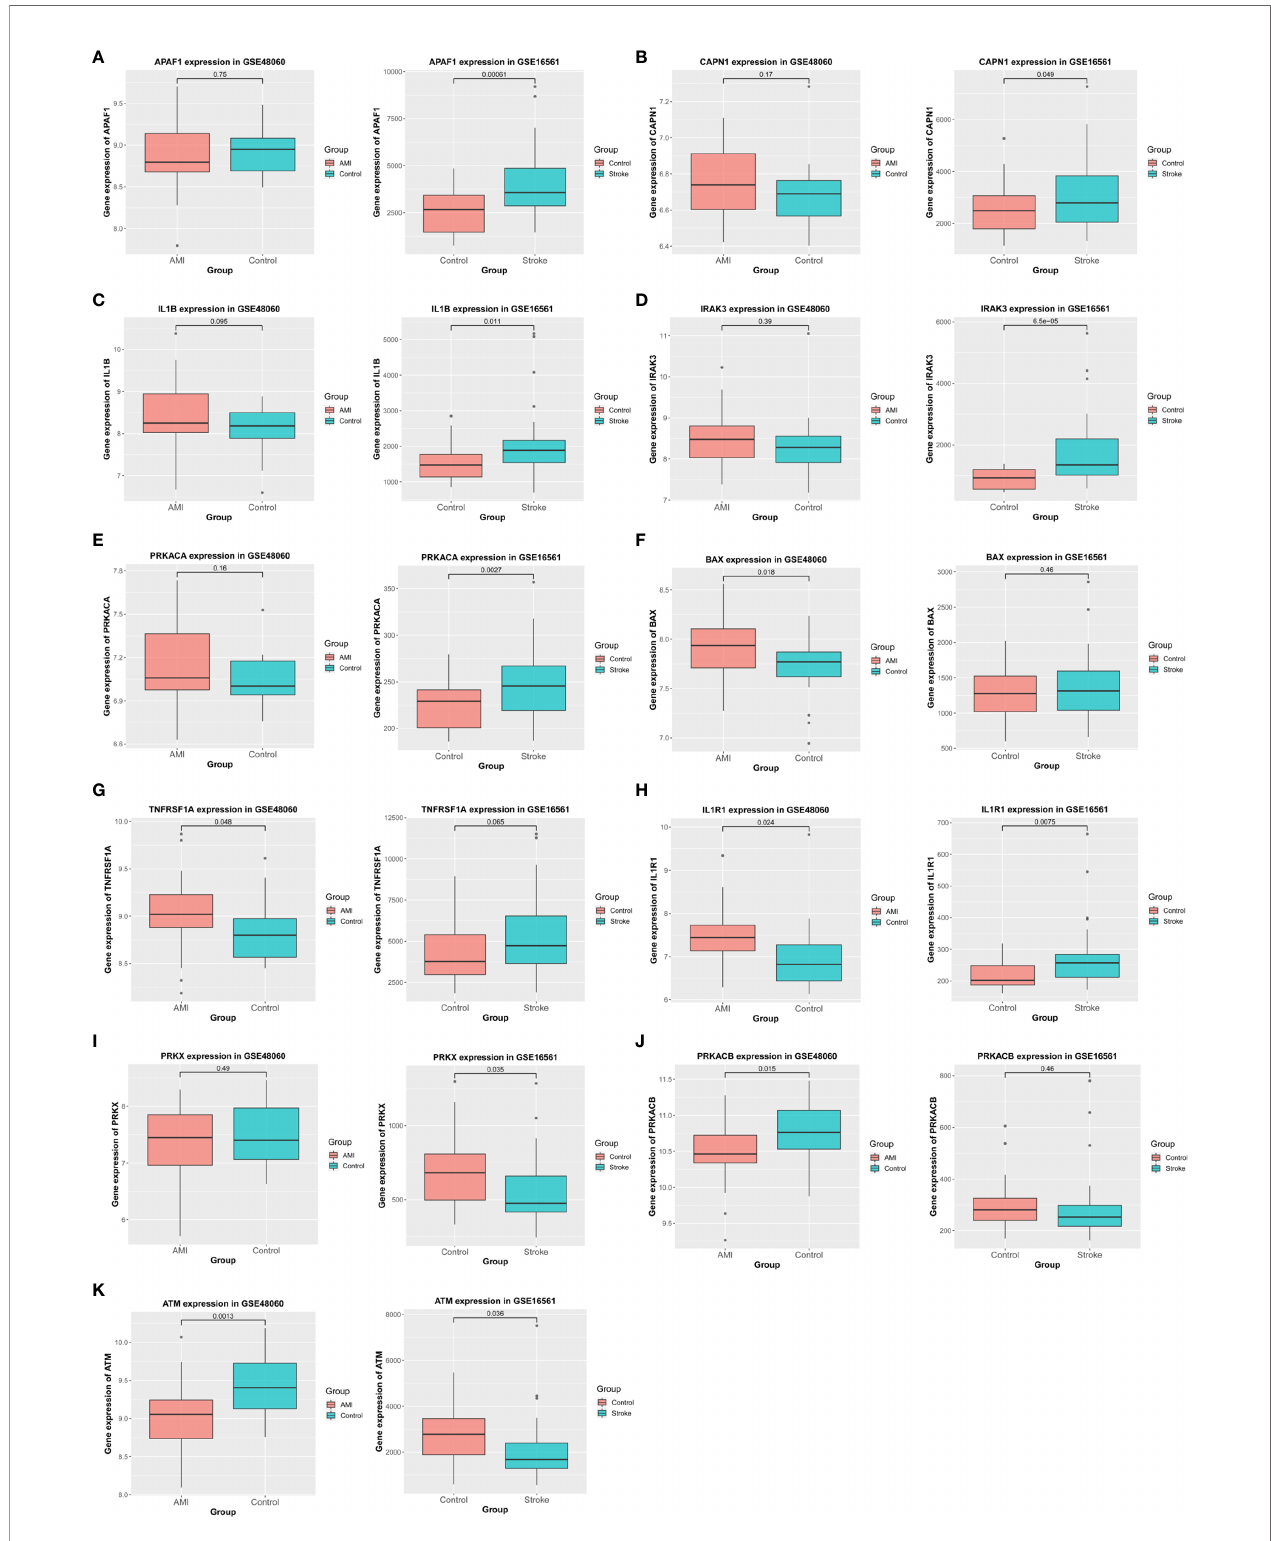
FIGURE 6 | Veri fi cation using validation datasets. (A – K) Veri fi cation of APAF1, CAPN1, IL1B, IRAK3, PRKACA, BAX, TNFRSF1A, IL1R1, PRKX, PRKACB, and ATM expression in the validation cohort. Statistical signi fi cance was determined by t -test. P -values of < 0.05 were considered statistically signi fi